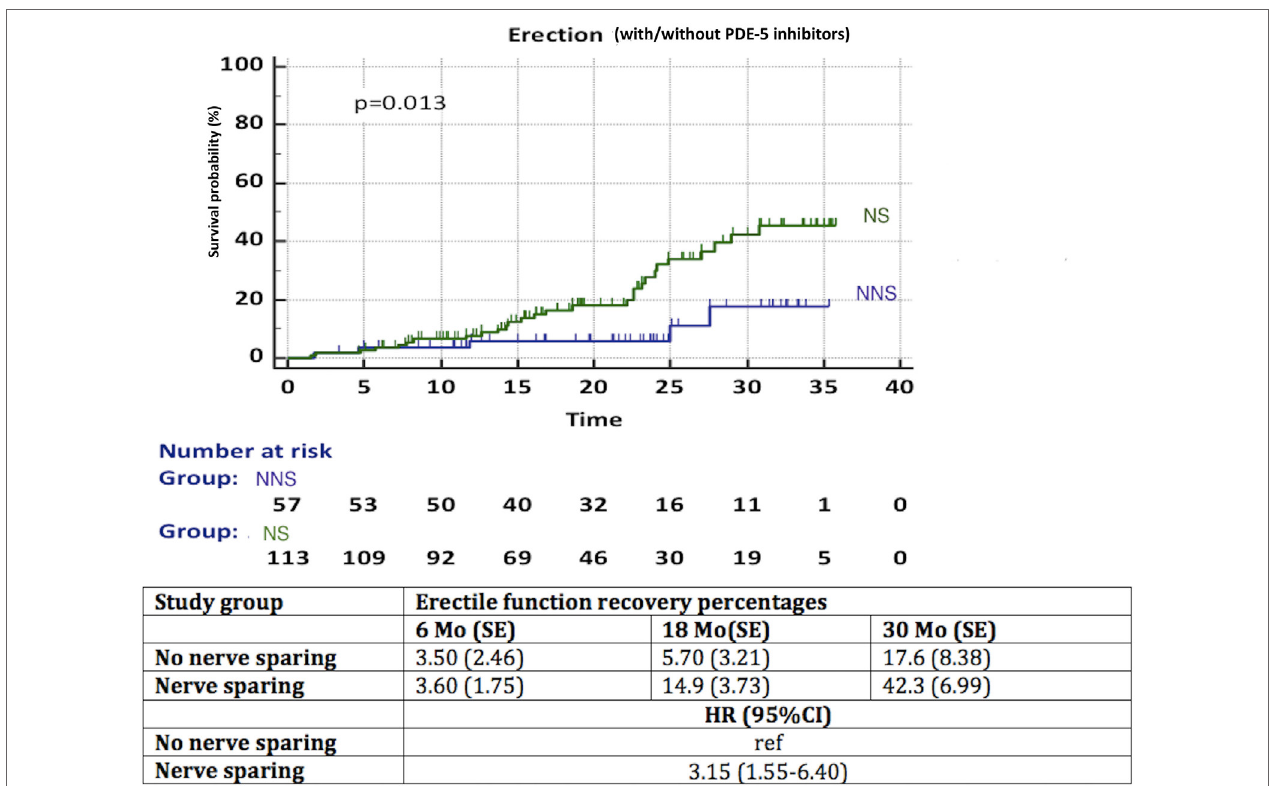
FigUre 4 | Recovery of erectile function in time among patients with nerve sparing (NS) versus no nerve sparing (NNS) technique during radical prostatectomy. HR, hazard ratio, mo, months, CI, confidence interval, ref, reference, SE, standard